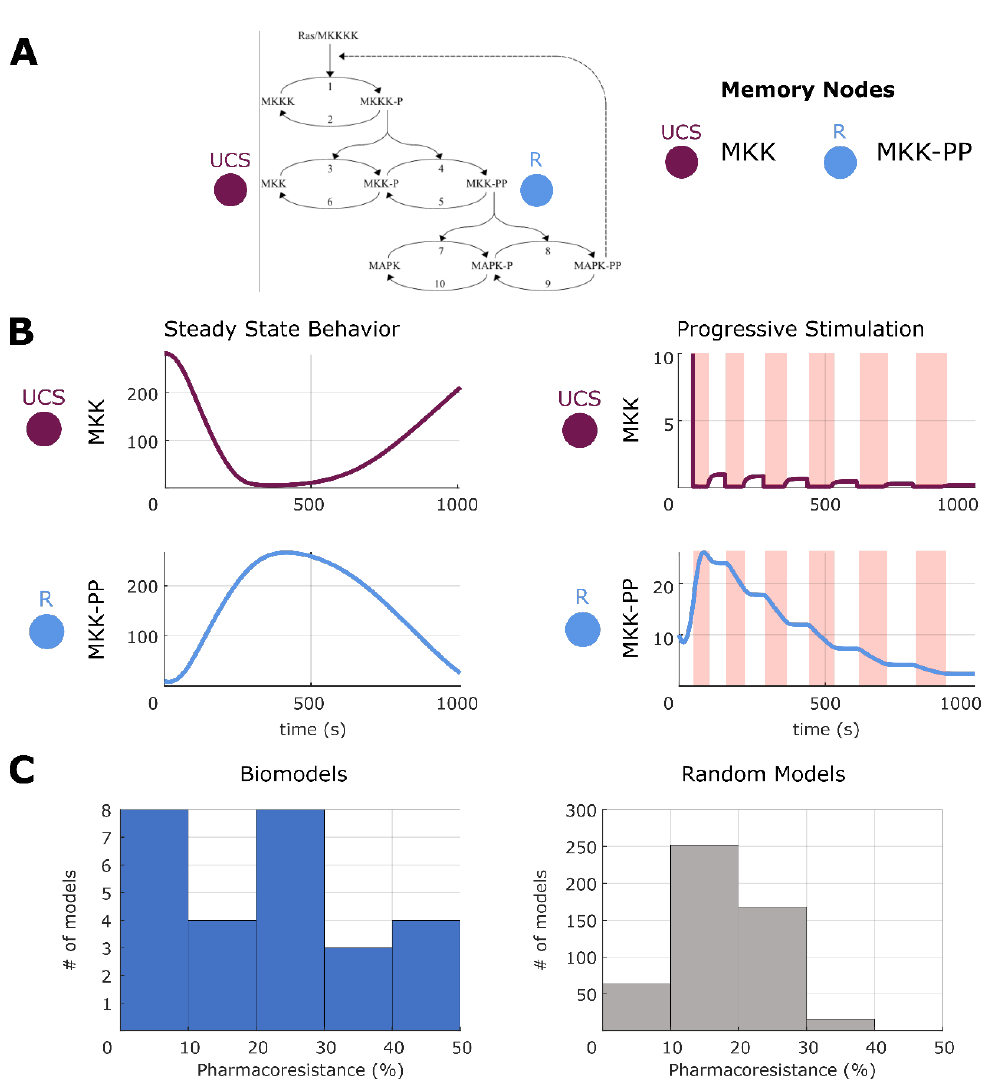
Figure 8. Habituation upon repeated stimulation of UCS. ( A ) An example of habituation in a potential memory model built from [76] that passed the pretest. ( B ) On the left, the steady state of the network with no stimulation. On the right, an example of habituation. Progressive stimulation (downregulation, red shaded area) of UCS results in less and less response from R (upregulation to downregulation). ( C ) Distribution of pharmacoresistance across all biological models and random networks. The x axis is measured as the percentage of memory models for a given biological model that show habituation, or pharmacoresistance. We performed a Wilcoxon rank sum test applicable to un-equal samples to test the similarity of the distributions and while there are differences, they are not significantly different ( p = 0.15).